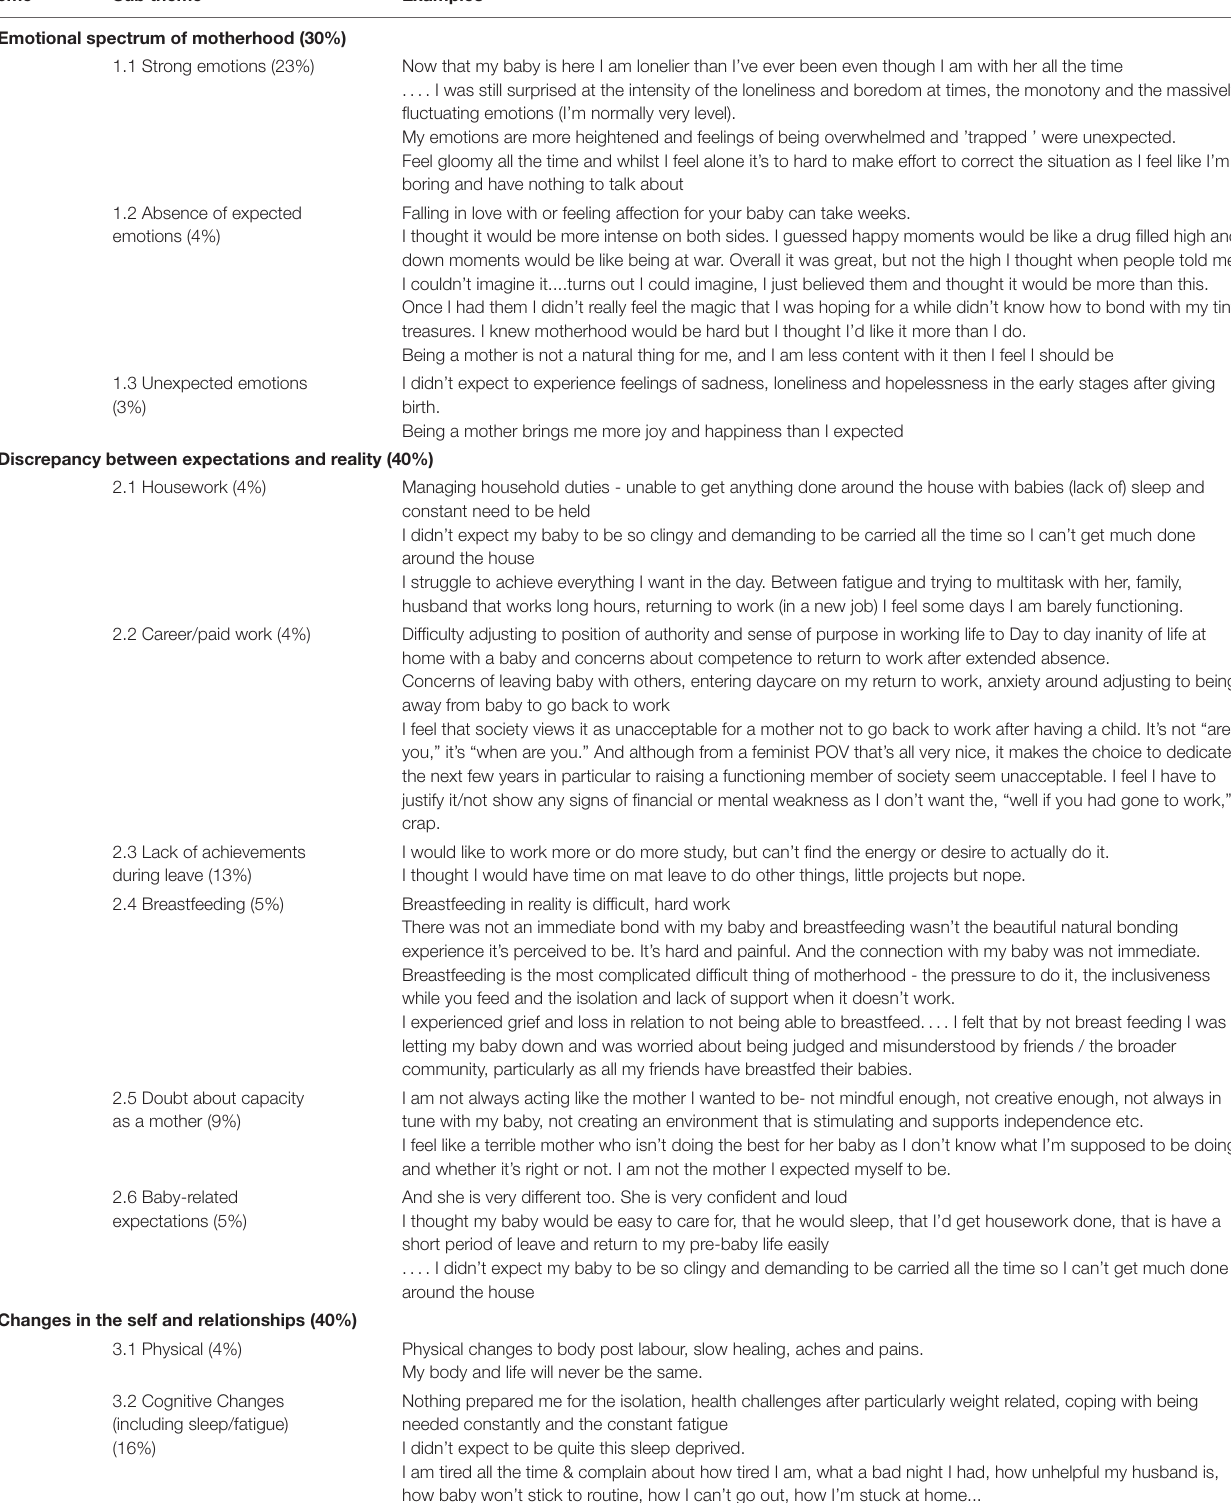
TABLE 2 | Themes, subthemes, and illustrative quotes for each theme that emerged in the thematic analysis (percentages in parentheses). Theme Sub theme